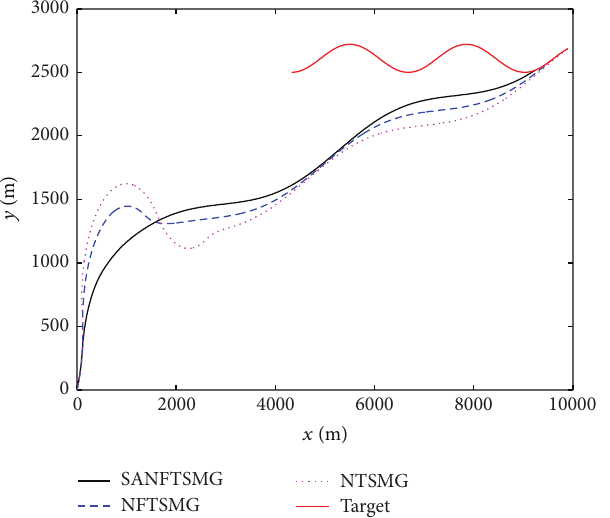
Figure 4: LOS angular rate (Case 1).